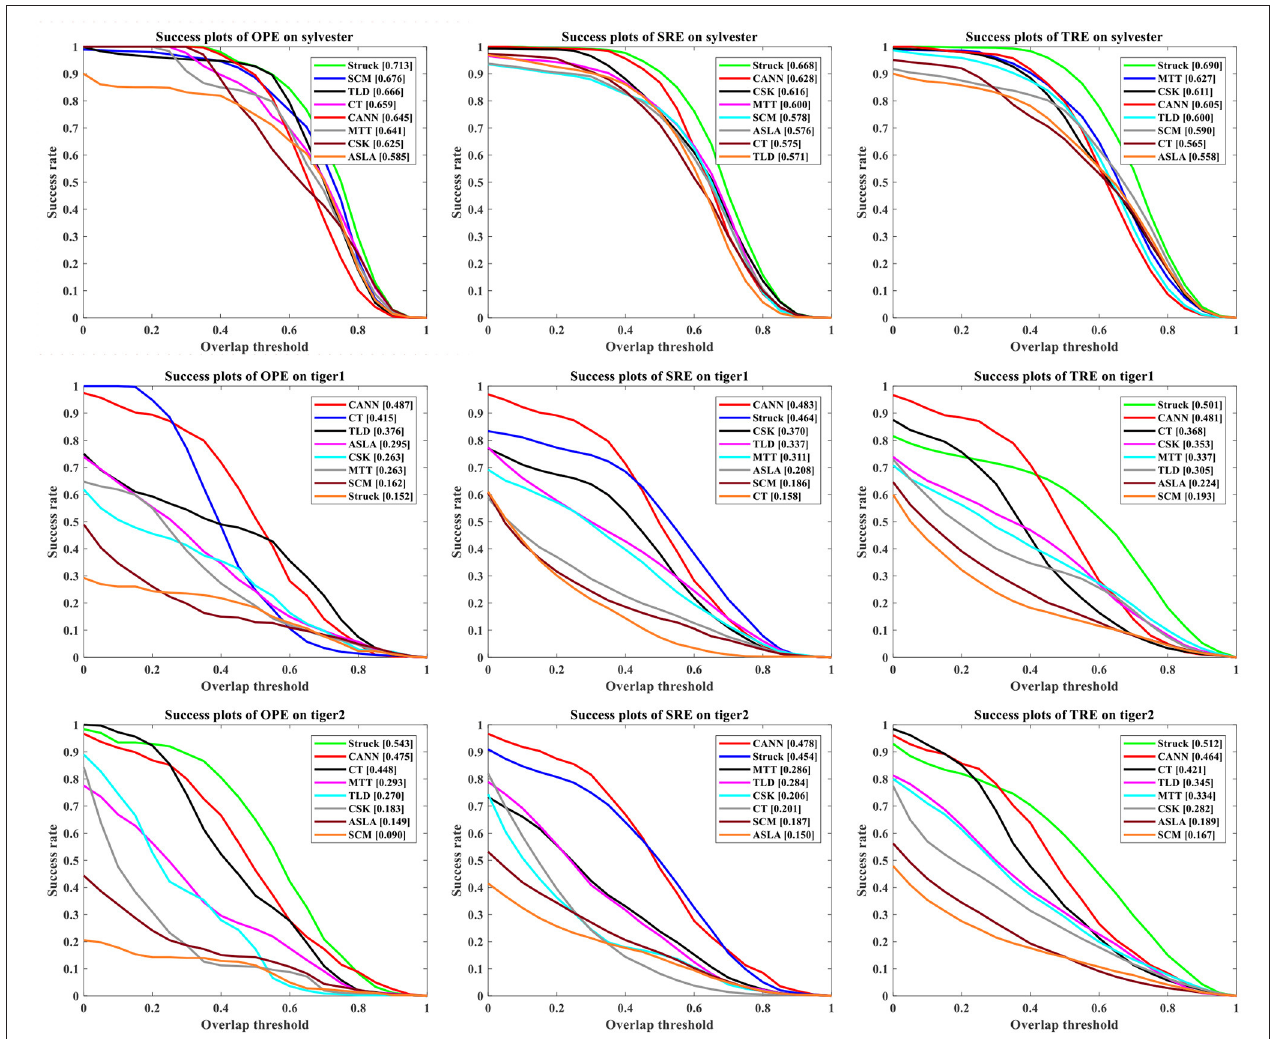
FIGURE 9 | Success rate of OPE, SRE and TRE, wherein the overall AUC score is listed in the legend. For clarity, only 8 trackers on three videos are